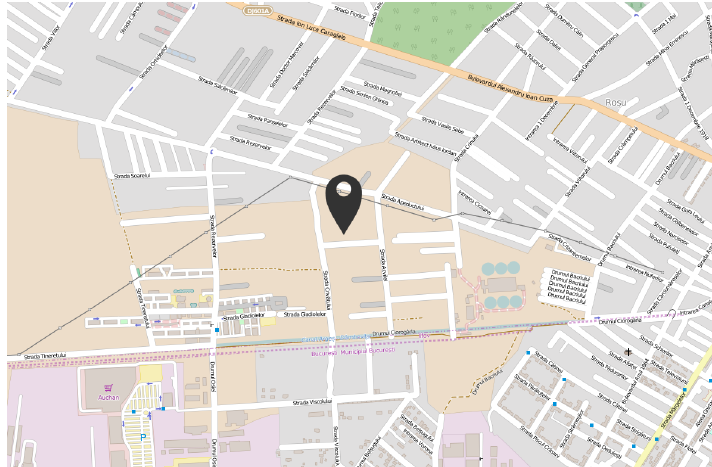
Figure 12. Ros u Town, location for the peripheral area ,